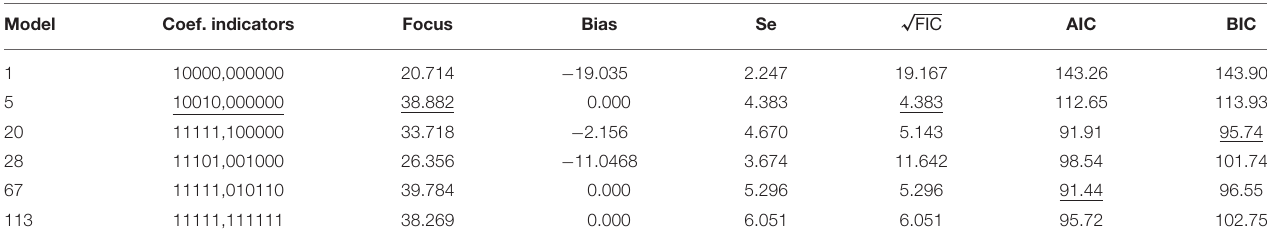
TABLE 1 | Bird species example.